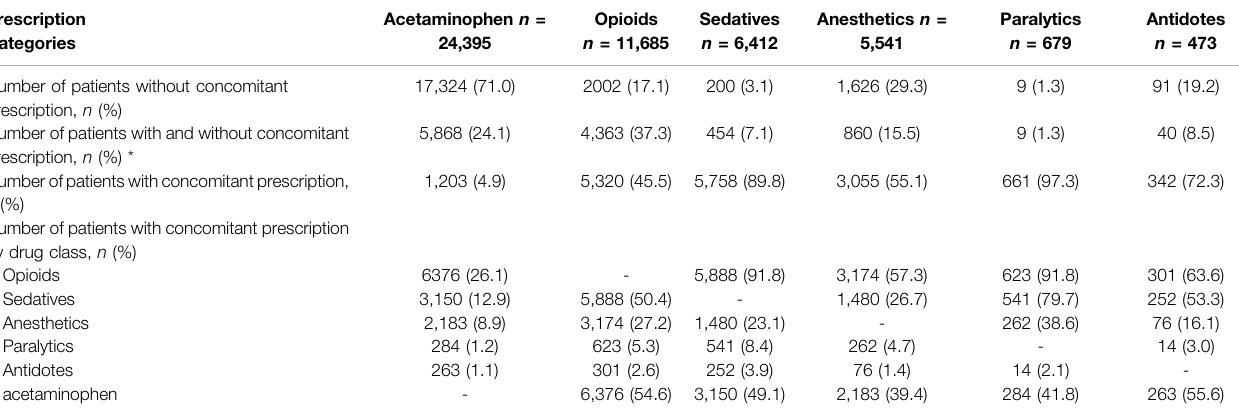
TABLE 2 | Number and proportion of patients with and/or without concomitant prescriptions by drug class. Prescription Categories Number of patients without concomitant prescription, n (%) Number of patients with and without concomitant prescription, n (%) *